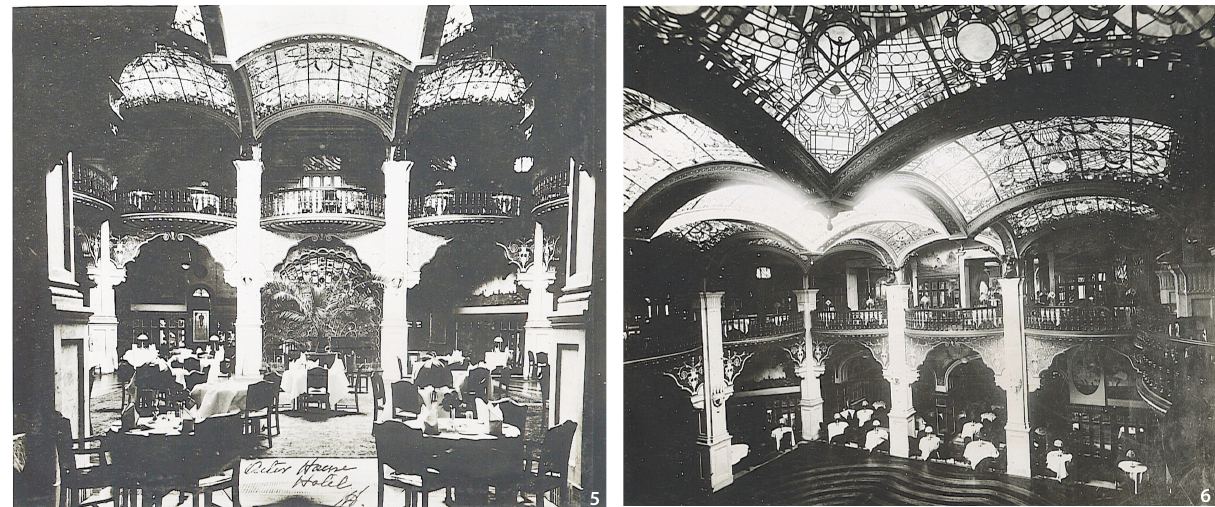
Figure 5, Figure 6 Views of the Astor House Hotel ballroom, photo taken in 1923 (Source: Abelardo Lafuente´s Personal Portfolio from Lafuente Family Private Archive, cited in Leonardo Pérez